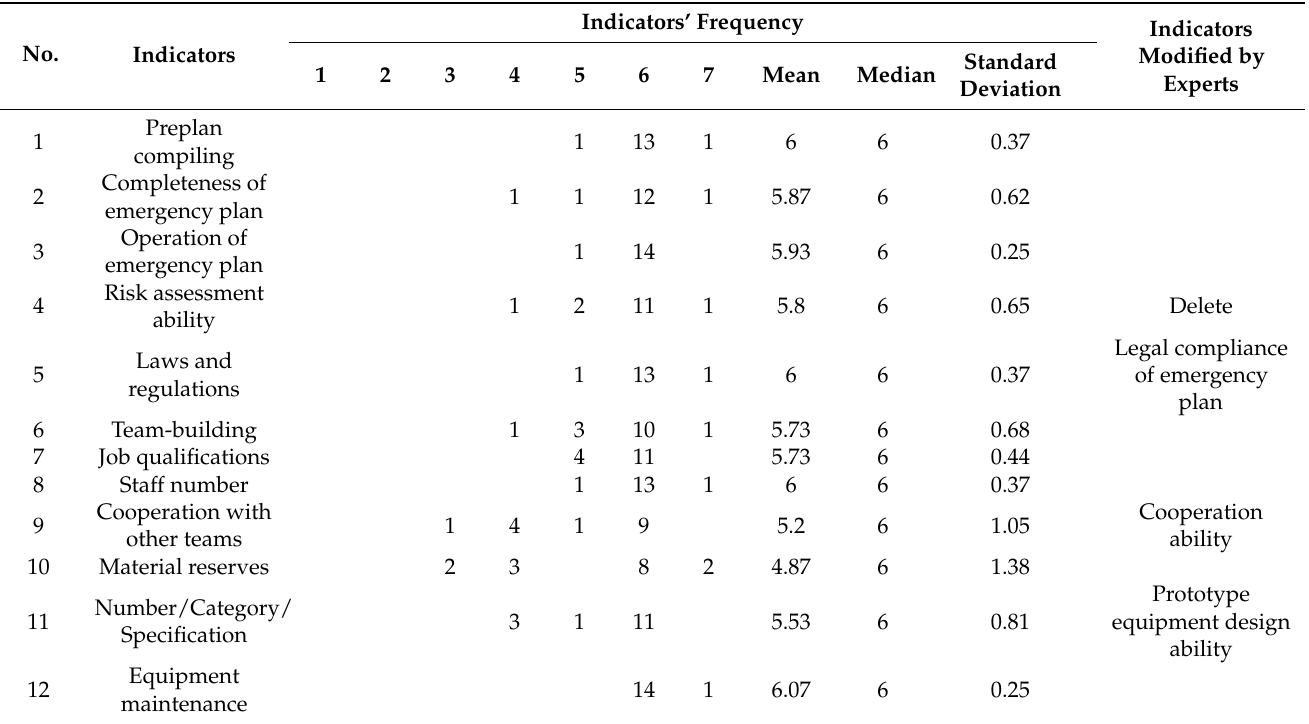
Table A2. Results of the first round of